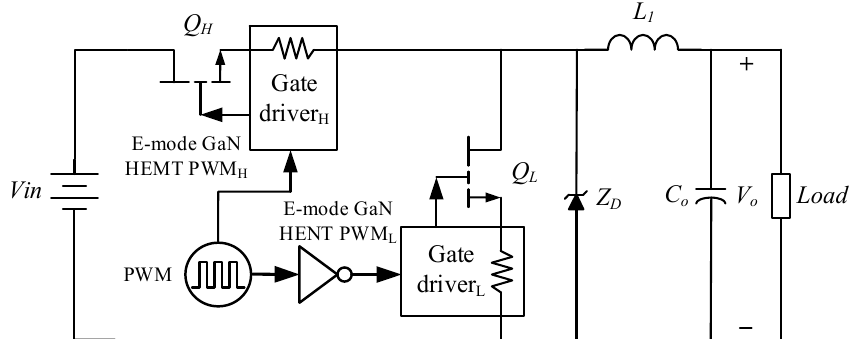
Figure 9. Application of gate driver circuit to the synchronous buck converter.